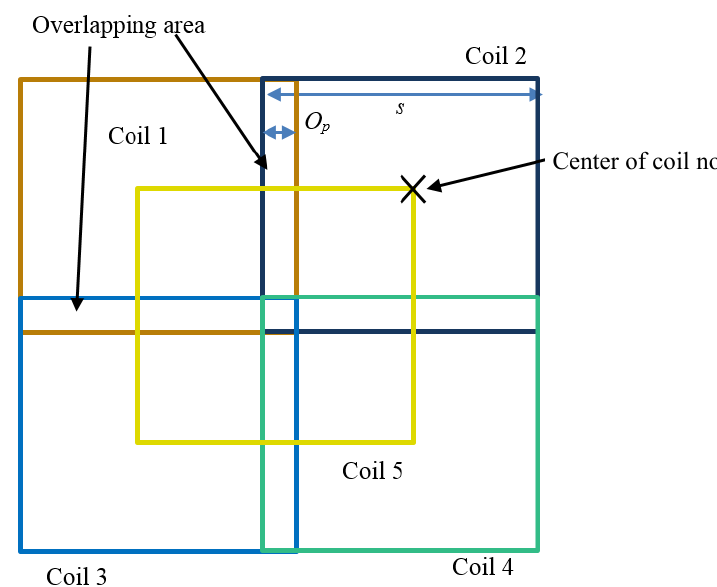
Figure 8. Configuration of the five transmitting planar coils.